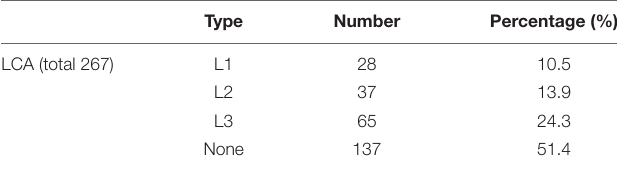
TABLE 1 | Distribution of the ascending branch of LCA.